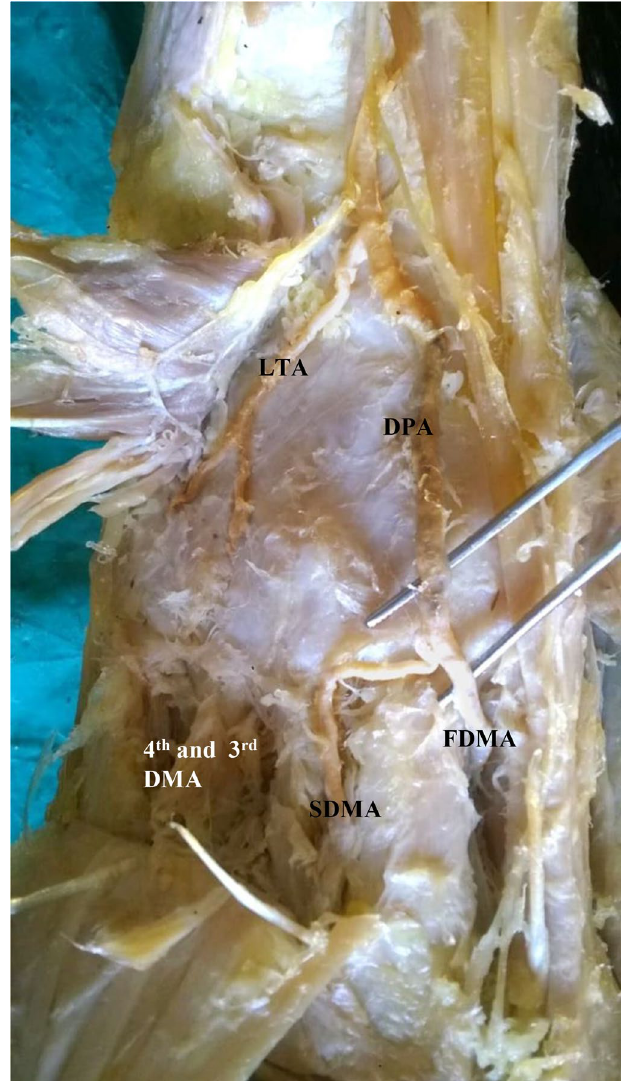
Figure 8. Absence of arcuate artery with 2nd dorsal metatarsal artery arising from dorsalis pedis artery, 3rd and 4th dorsal metatarsal arteries from plantar arch. SDMA-Second dorsal metatarsal artery, LTA-lateral tarsal